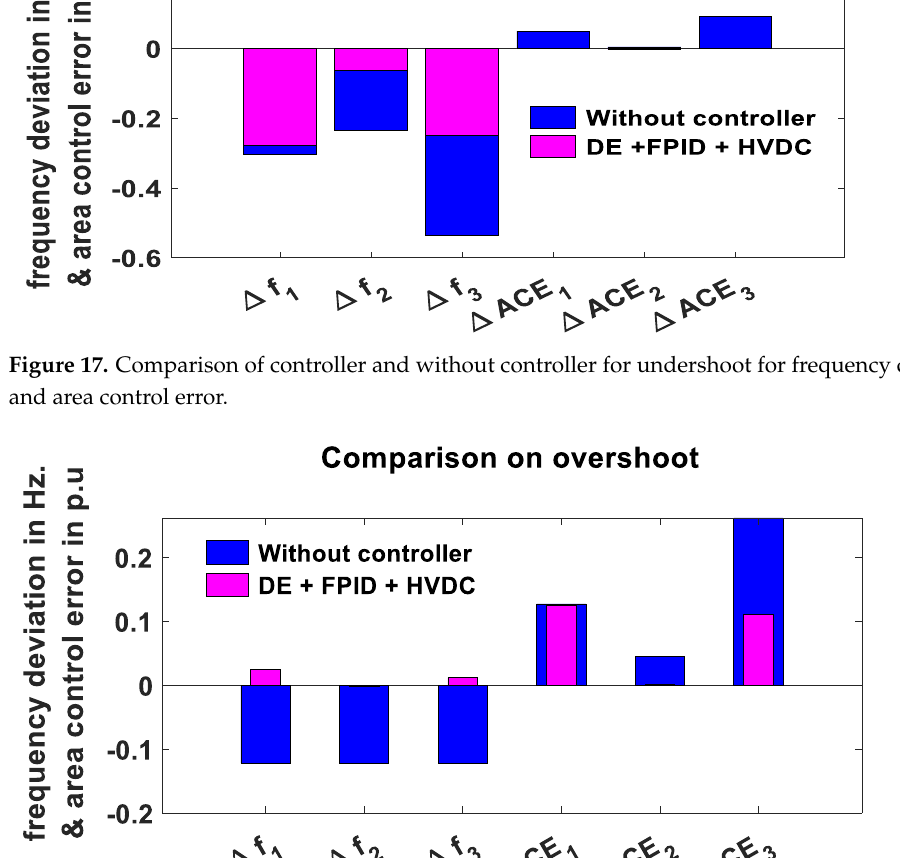
Figure 18. Comparison of controller and without controller for overshoot for frequency deviation and area control error.